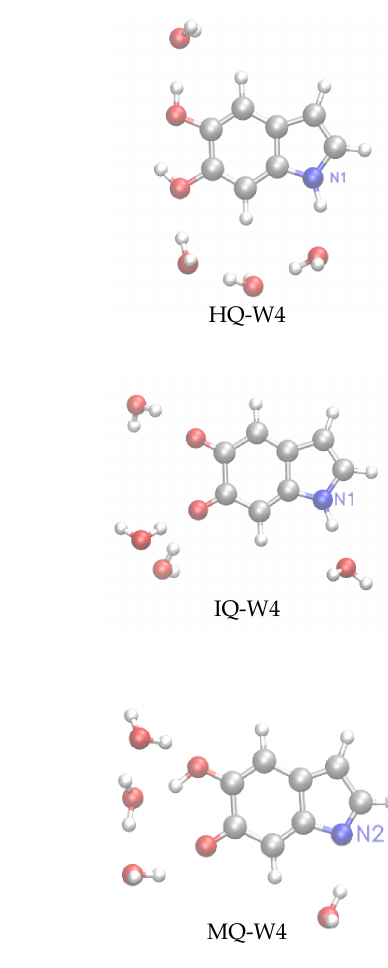
Figure 1. Left panels: structure of the hydroquinone (HQ), indolequinone (IQ), and quinone methide (MQ) monomers. Right panels: microsolvated structures with for water molecules HQ-W 4 , IQ-W 4 , and MQ-W 4